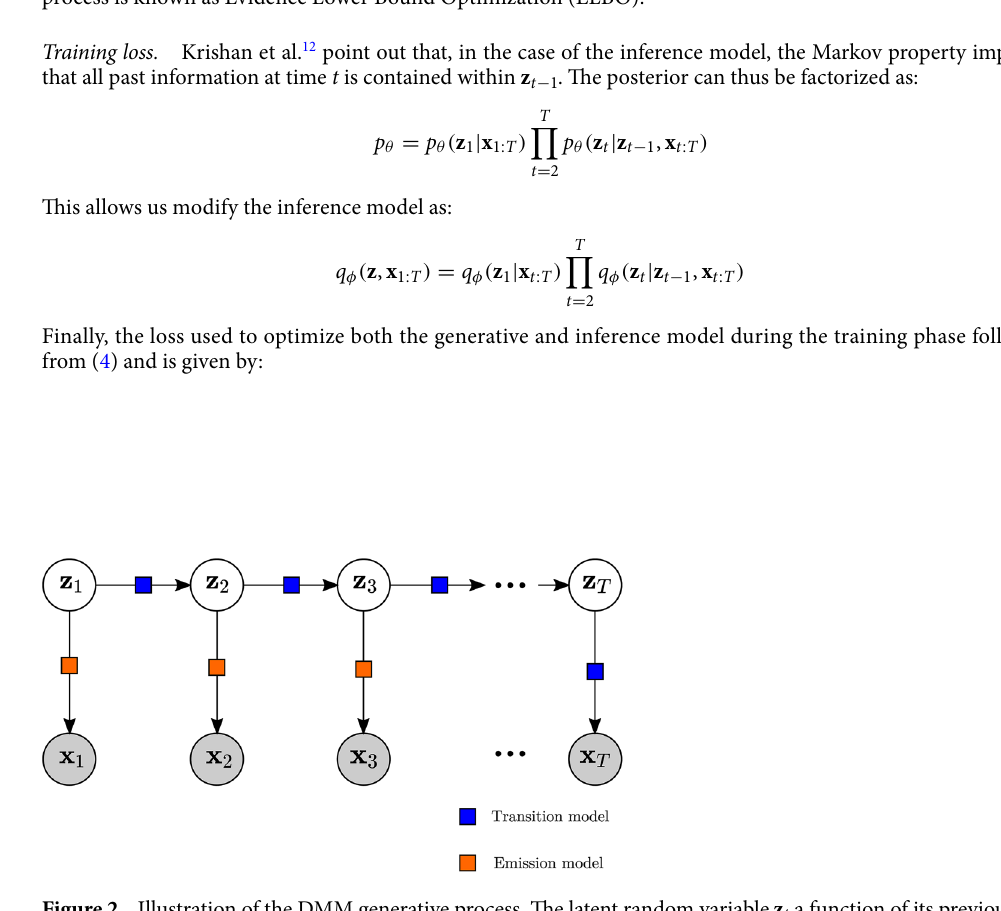
Figure 2. Illustration of the DMM generative process. The latent random variable z t a function of its previous instance z t − 1 passed through the transmission model, enforcing a Markov property on the latent variable. At each time step, observations x t are generated by the emission